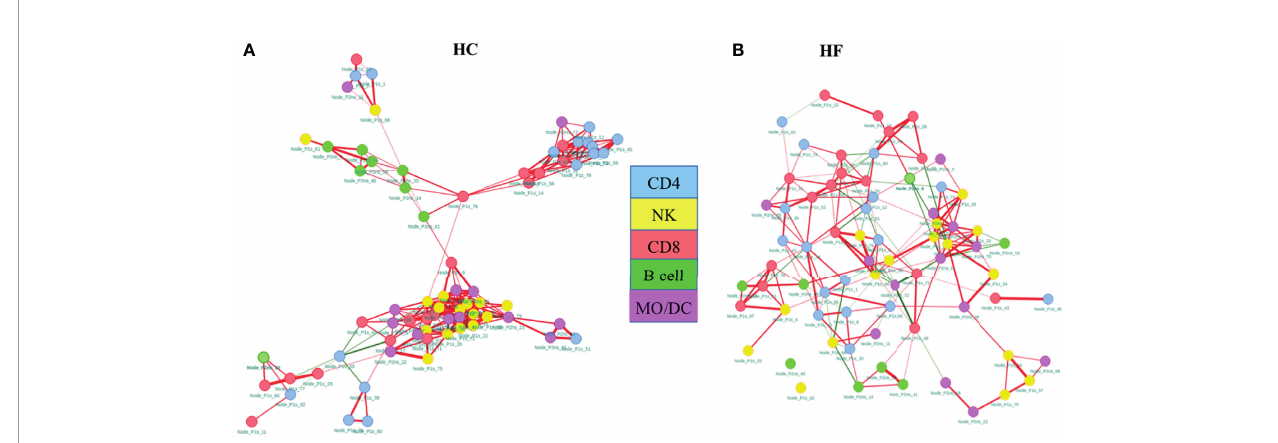
FIGURE 3 | Co-regulatory network of immune subsets in heart failure (HF) disease shows highly modular structure compared to healthy controls (HC). Network analysis shows increased intracellular interaction of B and NK cells in the HF immunome network (A) compared to HC immune cell network (B) . Network of nodes (cellular subsets) were created and plotted as force directed layout. The color of the nodes indicates the cellular phenotypes. The edges (line connecting the two nodes) represent the connection between the nodes. The colors of the edges indicate the correlation direction: red = positive, green = negative. Absolute correlation cutoff of 0.6 or greater were used to established edge between two